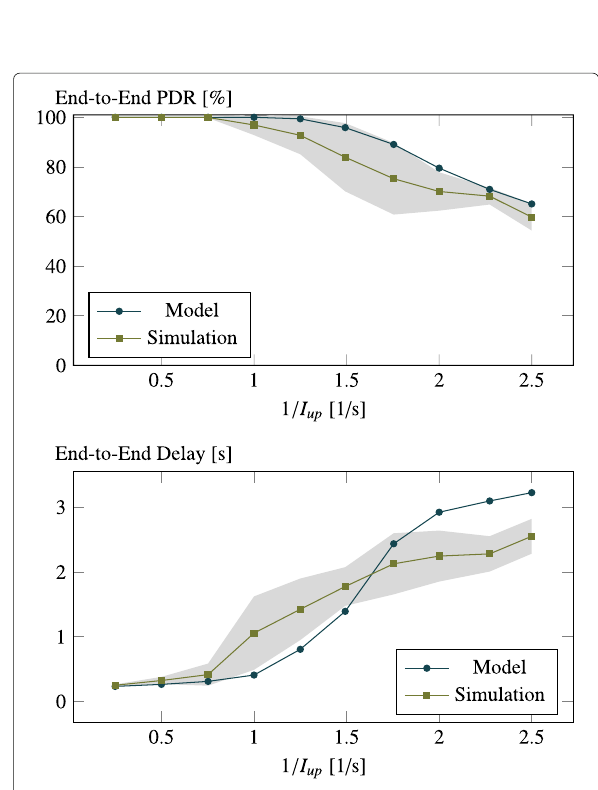
Fig. 10 Comparing a Sender-based Dedicated Orchestra